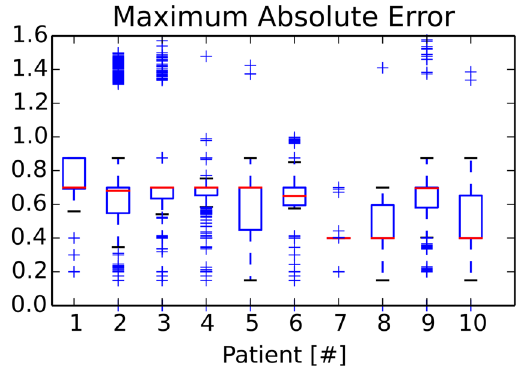
Figure 7. Change of segmentation model: Force metric MAE per path.